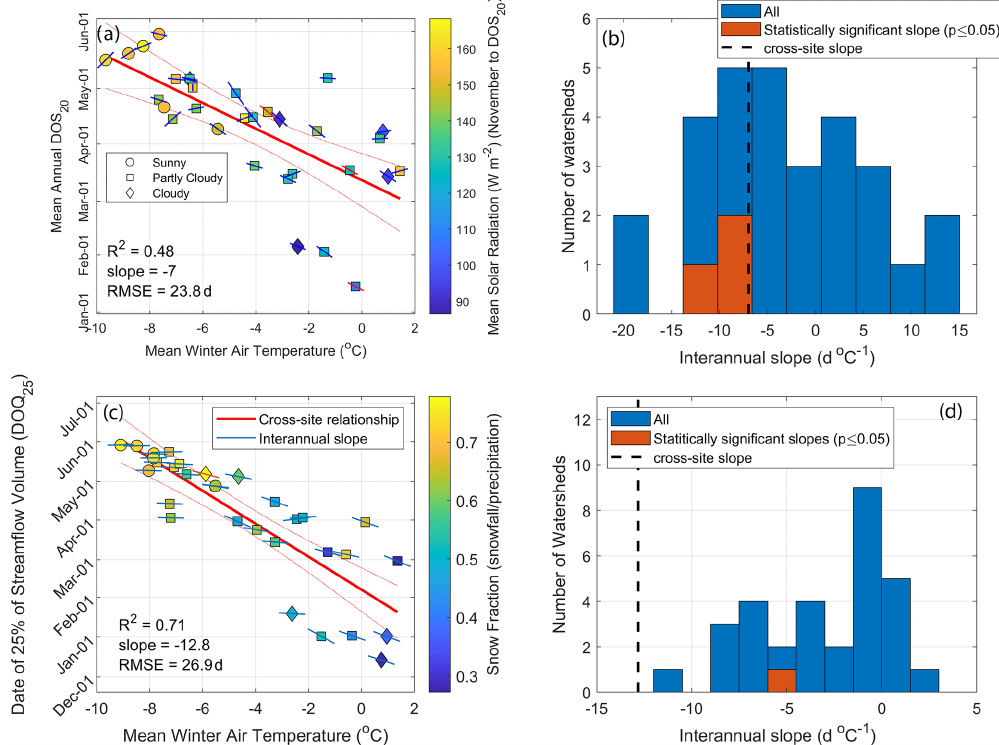
Figure 3. Panels (a) and (c) show cross-site relationships between mean winter air temperature (November to February) and DOS 20 and the date of 25% of the annual streamflow volume (DOQ 25 ), respectively. Slopes of individual sites’ interannual relationships are shown as the lines on top of each symbol, where statistically significant ( p value ≤ 0.05) slopes are red. Non-significant interannual slopes are presented to show the overall tendency in their spatial distribution. Symbols are associated with the mean annual percentage of snowmelt days under clear-sky conditions. Sunny sites (circles) have > 90% clear-sky snowmelt days, partly cloudy sites (squares) have between 70% and 90%, and cloudy sites (diamonds) have < 70% clear-sky snowmelt days. Clear-sky snowmelt days are defined as those with more than 80% of the potential clear-sky solar radiation. Panels (b) and (d) show histograms of interannual slopes (for all watersheds and those with statistically significant relationships), and the cross-site relationships are presented in their respective left